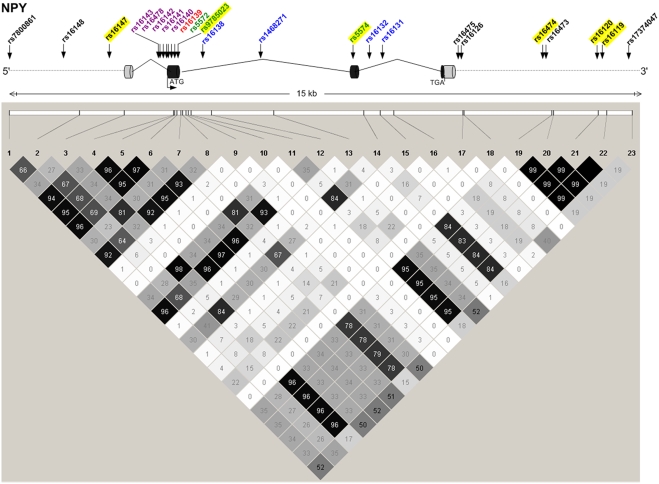

NPY structure, genotyped SNPs, and LD between SNPs.
NPY gene structure is displayed diagrammatically (top), with exons symbolized as cylinders, and sites of translation initiation (ATG) and termination (TGA) indicated. Genotyped SNPs are noted with arrows and color-coded: coding-nonsynonymous (red); coding-synonymous (green); intronic (blue); mRNA-untranslated region (lavender); 5′ and 3′ gene-flanking region (black). The bottom panel constitutes a LD graphic with R2 values (n×102) between SNPs; darker squares signify higher degrees of LD. SNPs genotyped as part of this study are highlighted in yellow.